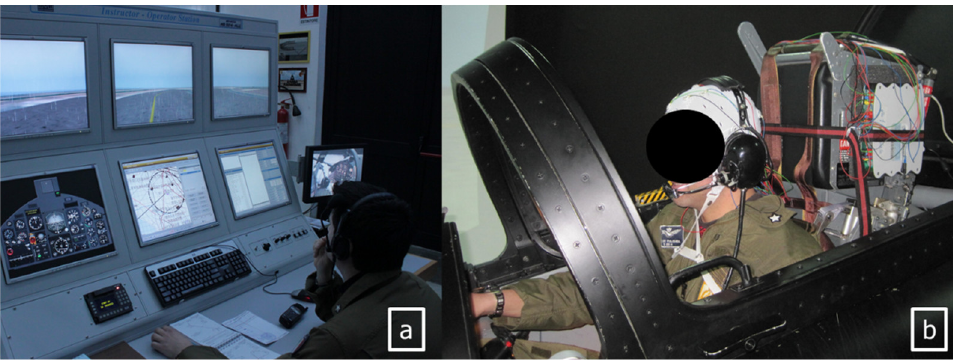
Figure 1. Flight simulator facility at the 61° Stormo in Galatina (Italy): ( a ) the MB339 alpha simulator platform allowed the instructors to monitor and communicate with the pilots and to interact with the aircraft for inducing three unusual attitudes; ( b ) the pilots’ brain (EEG) and heart (ECG) activity was acquired for the entire flight simulation.